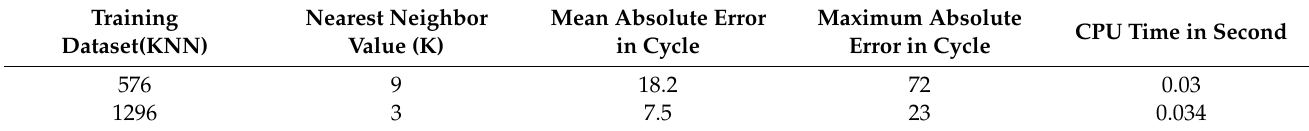
Table 22. KNN result comparison with different datasets.